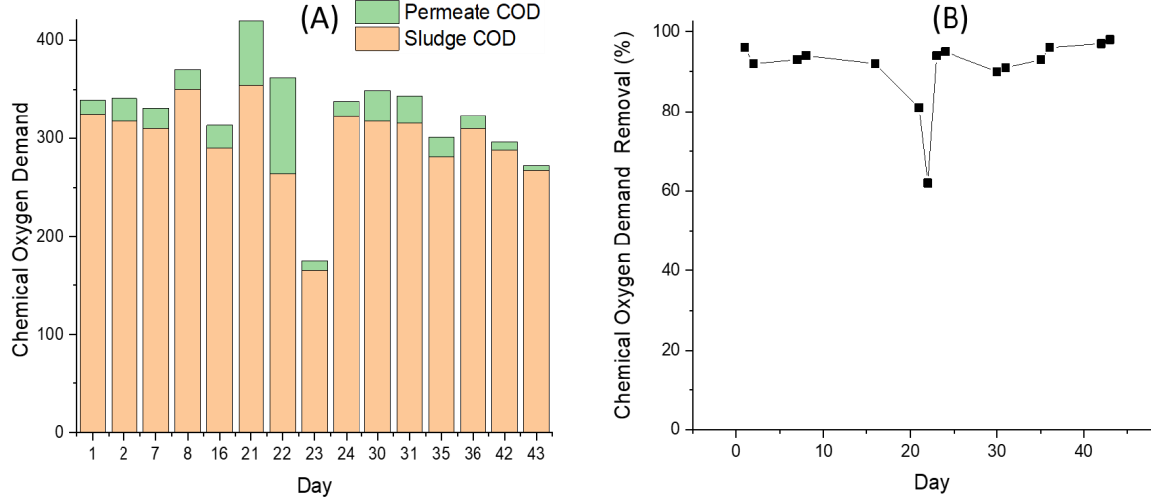
Figure 6. ( A ) Chemical oxygen demand permeate and mixed liquor and ( B ) the removal efficiencies showing the contribution of the biofilm in removing organics. Notice that the feed and the permeate COD values in ( A ) are stacked.